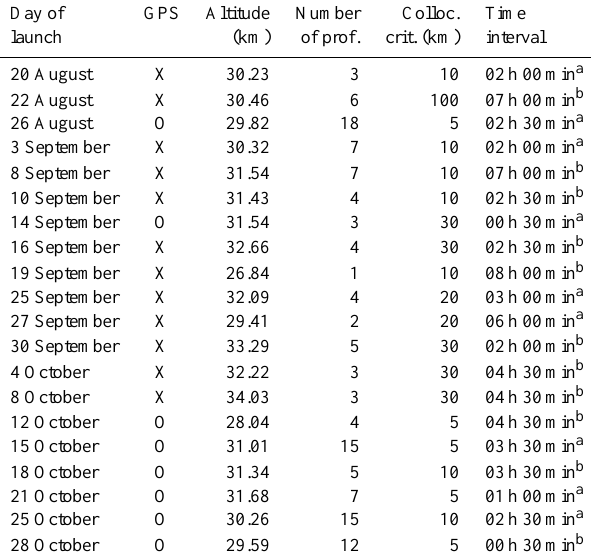
Table 1. Balloon data used in this study. First column presents the month and day the balloon was launched; second column indicates whether the balloon was equipped with a GPS (“0”) or not (“X”). Third column gives the bursting altitude of the balloon above sea level. Then the number of IASI profiles considered for each compar- ison and the collocation criteria are respectively given in the fourth and fifth column. The sixth column gives an approximation of the time interval between the middle of the balloon flight and time when the satellite passed above the site. Letters “a” and “b” respectively stand for “after” and “before” satellite passing. Day of GPS Altitude